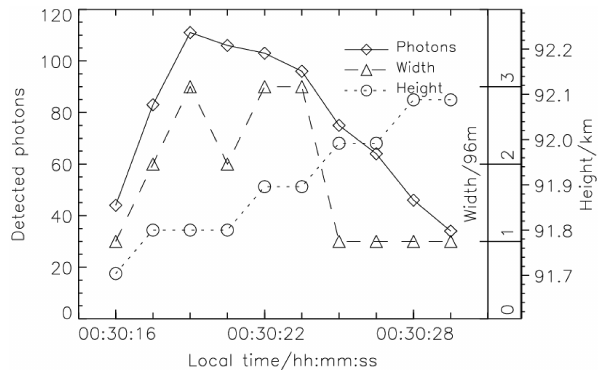
Figure 13. Evolution of a meteor trail observed near the peak back- ground of the Na layer, which occurred on 27 June 2011. Figure 14. Variations of the trail peak intensity, the width and the peak height, corresponding to Fig. 13.